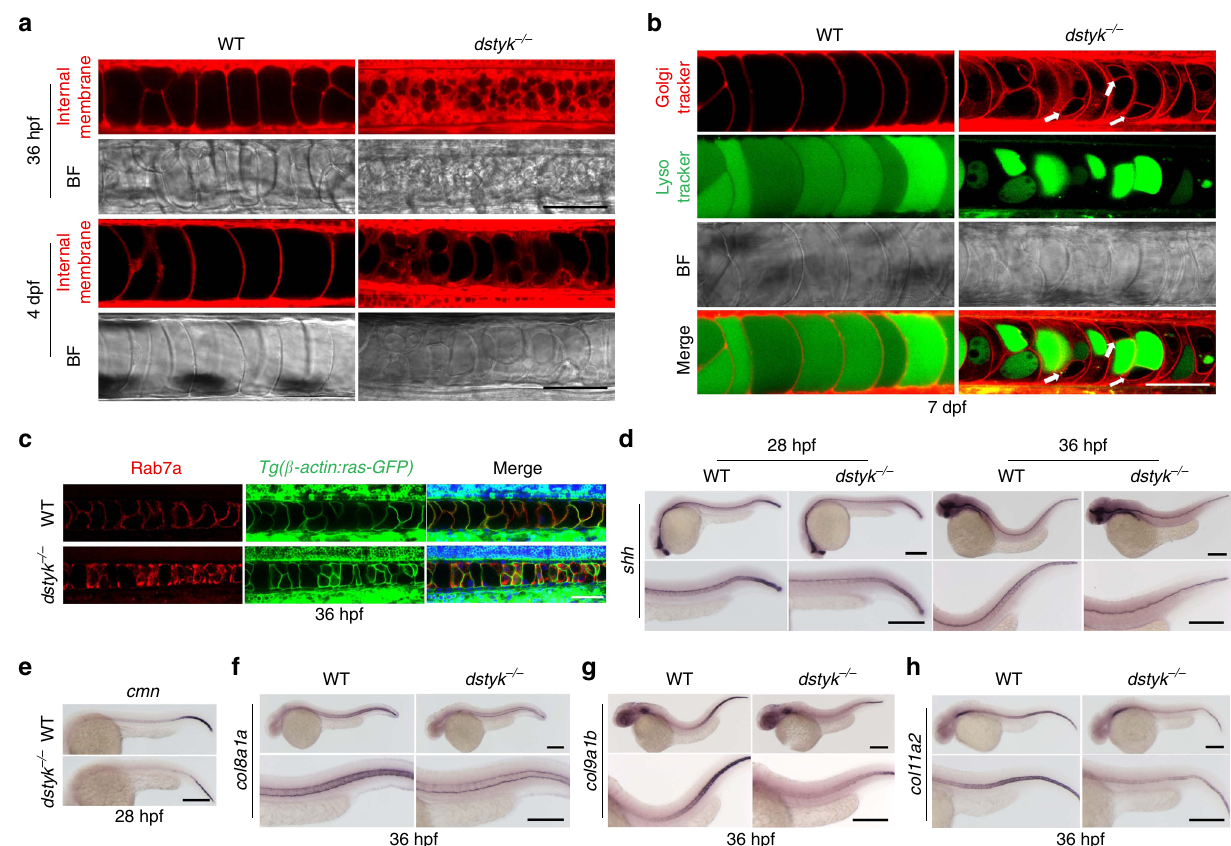
Fig. 5 Dstyk gene mutation leads to abnormal vesicle traf fi cking and dysregulated notochord vacuoles biogenesis. a Live confocal images of notochord for WT and dstyk mutant in bright- fi eld and staining with MED at 36 hpf (top) and 4 dpf (bottom). b Live confocal images of notochord for WT and dstyk mutant dyed with Golgi tracker BODIPY TR Ceramide and LysoTracker Green at 7 dpf. Note that every notochord cell in the mutant was composed of one LysoTracker Green labeled vacuole (green) and at least one round cystic structure (white arrows) that can be labeled by Golgi tracker. c Confocal images of immuno fl uorescent staining of WT and dstyk mutants for Rab7a at 36 hpf in the background of Tg( β -actin:ras-GFP) . d ISH of shh at 28 hpf (left) and 36 hpf (right) of WT and dstyk mutants. Magni fi ed images in the bottom column. e ISH of cmn at 28 hpf of WT and dstyk mutants. f – h ISH of col8a1a ( f ), col9a1b ( g ) and col11a2 ( h ) at 36 hpf of WT and dstyk mutants. Magni fi ed images in the bottom column. Scale bar represent 50 μ m in ( a – c ), 200 μ m in ( d – h